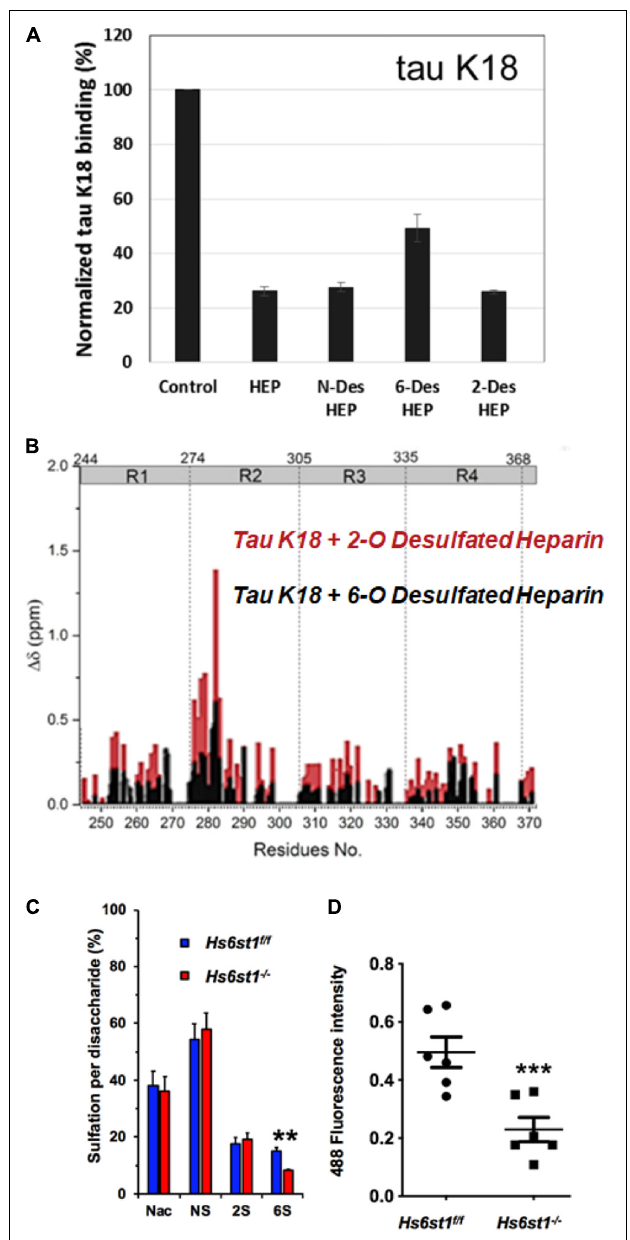
FIGURE 4 | Evidence For the Role of 6- O Sulfation in HS Tau Binding. (A) Chemical removal of 6-O sulfo groups inhibits the ability of heparin to compete for K18 tau (a truncated construct consisting of the 4R MTBR of tau) binding in an SPR competition experiment compared to other sulfo- groups. In this SPR competition experiment, heparin or its analog in solution inhibits the binding between tau and heparin immobilized on the SPR chip. Heparin (HEP) and N-desulfated and 2-O-desulfated HEP can inhibit tau-heparin binding at the same level, while 6-O-desulfated HEP does not inhibit binding as efficiently. (B) NMR studies indicate that K18 tau exhibits significantly greater Chemical Shift Perturbation (CSP) when exposed to 2- O desulfated heparin compared to 6- O desulfated heparin, indicating the importance of 6-O sulfation in tau/HS interactions. The knockout of a 6-O HS sulfotransferase ( Hs6st1 ) in lung endothelial cells significantly reduces (C) the amount of 6- O sulfated HS and (D) the uptake of fluorescently labeled Tau. Adapted from